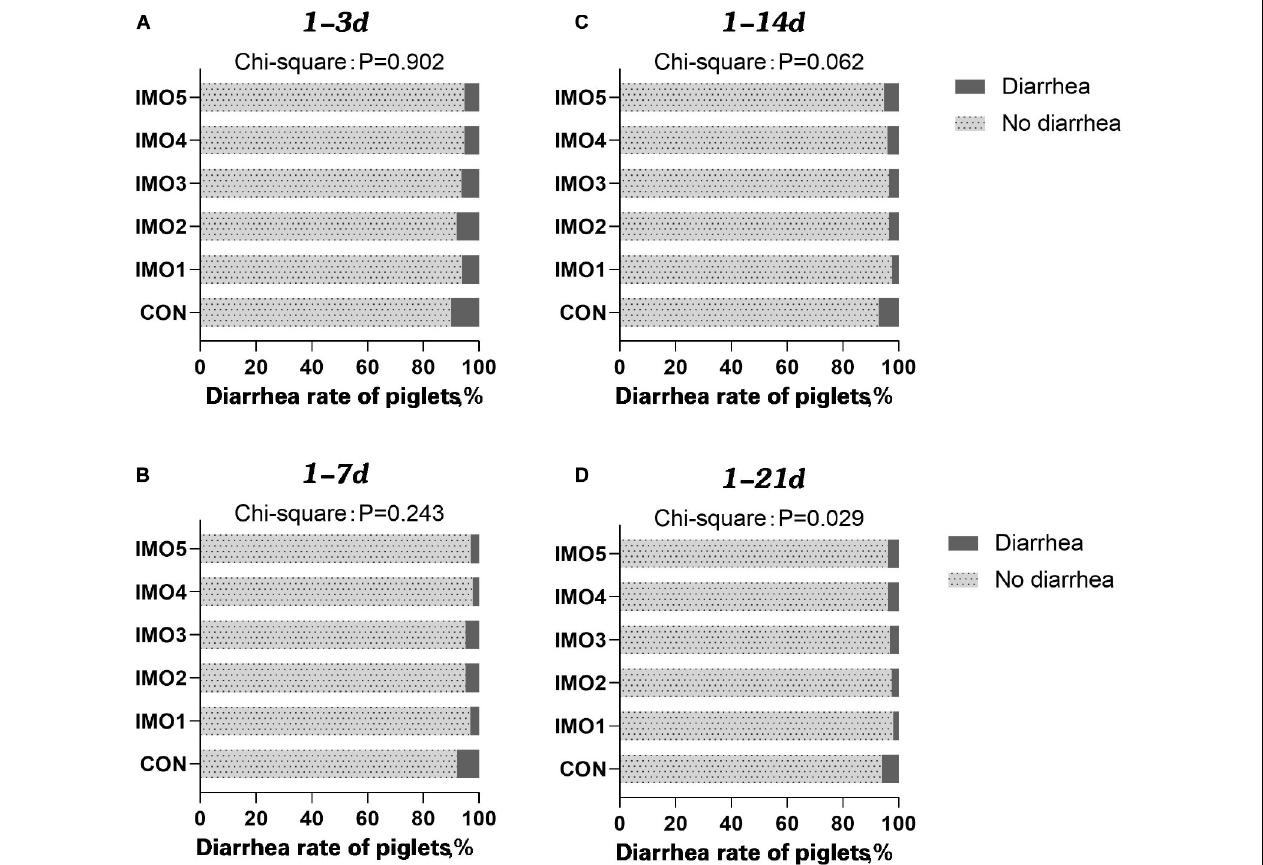
FIGURE 1 | Effects of different doses of IMO on the diarrhea of suckling piglets in a different stage [ (A) , 1–3 days; (B) 1–7 days; (C) 1–14 days; (D) 1–21 days]. Data were compared with use of chi-square analysis ( P < 0.10).